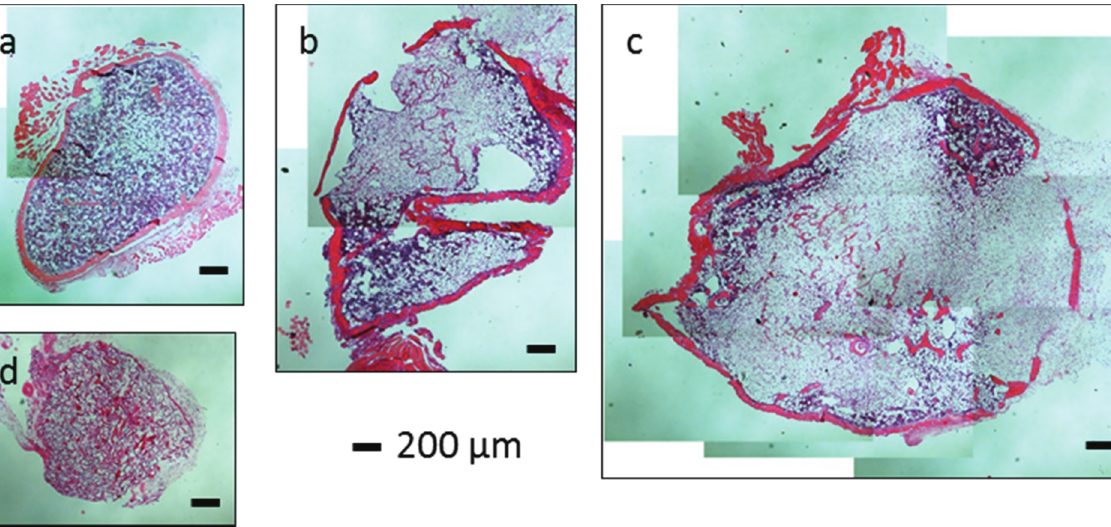
Figure 7. Microscopic analysis of ossicle sections after 4 weeks of implantation (H & E-staining). ( a ) implant: collagen sponge loaded with CS(42)-TPP nanoparticles containing 1 μg BMP-2; ( b ) implant: collagen sponge loaded with CS(42)-TPP nanoparticles containing 2 μg BMP-2; ( c ) implant: collagen sponge loaded with CS(42)-TPP nanoparticles containing 5 μg BMP-2 and ( d ) implant: collagen sponge loaded with CS(42)-TPP